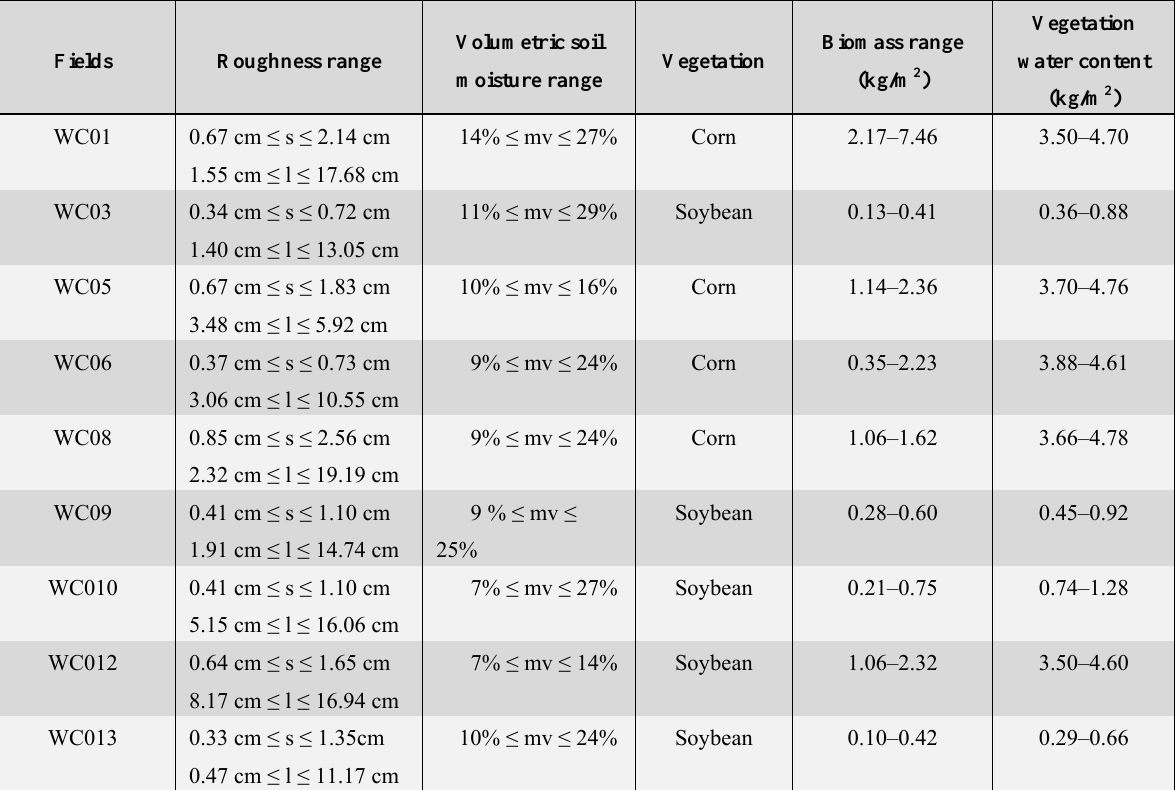
Table 1 . Some characteristics of the SMEX’02 fields analyzed in the work. Fields Roughness